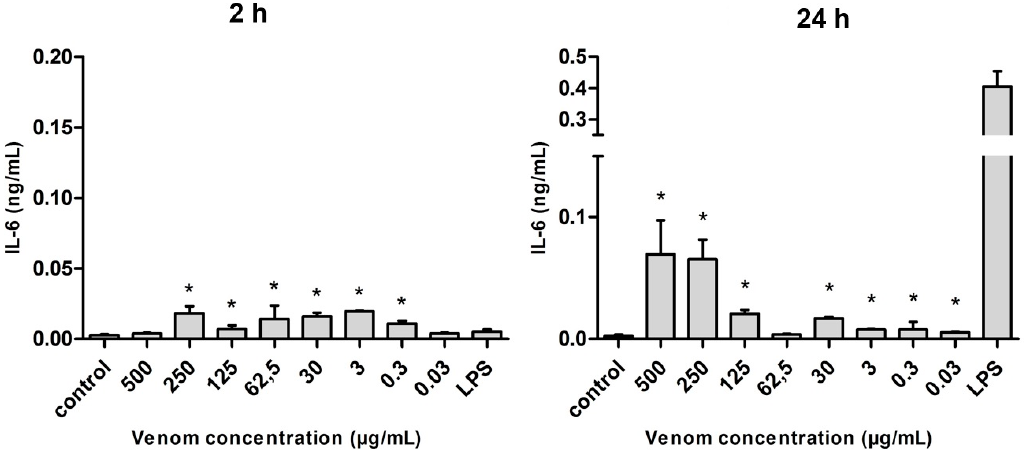
Figure 5. Amount of IL-6 (in ng/mL) released after the stimulus with Neoponera villosa venom. Values expressed in mean + standard deviation. Control: macrophages with supplemented culture medium alone. LPS: macrophages stimulated with 2 μ g/mL LPS. * Denotes significantly different ( p < 0.05).